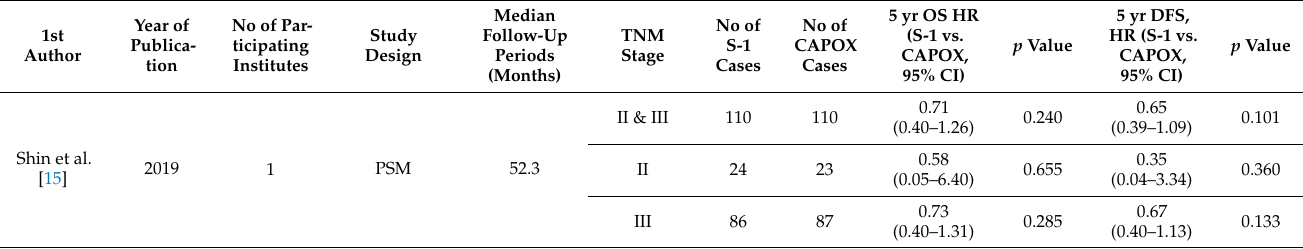
Table 1. Summary of studies and HRs of S-1 compared with CAPOX as reference for overall survival and disease-free survival with gastric